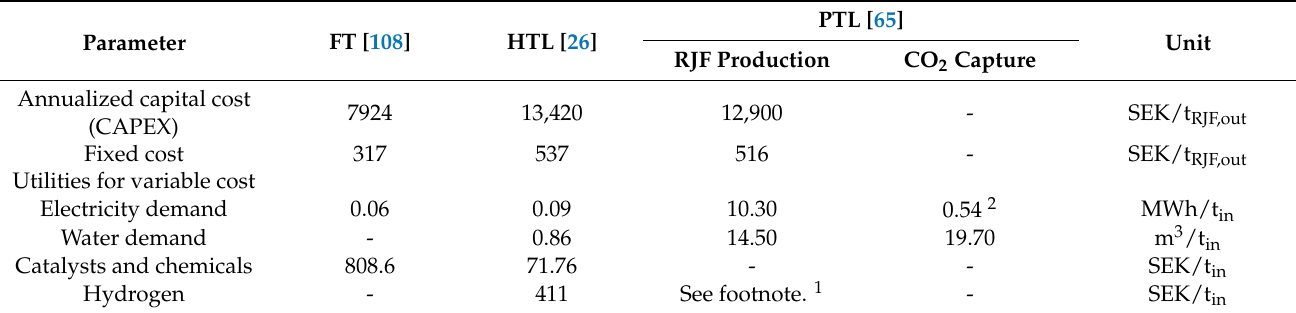
Table 5. Economic parameters of the studied RJF conversion pathways.